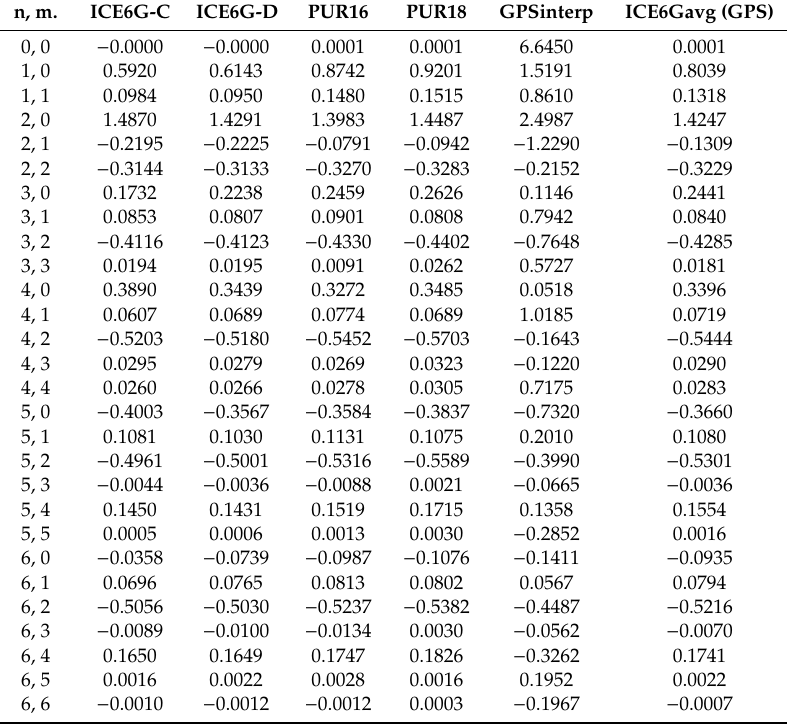
. X − 11 yr − 1 ) 1 . C nm (Unit: 10